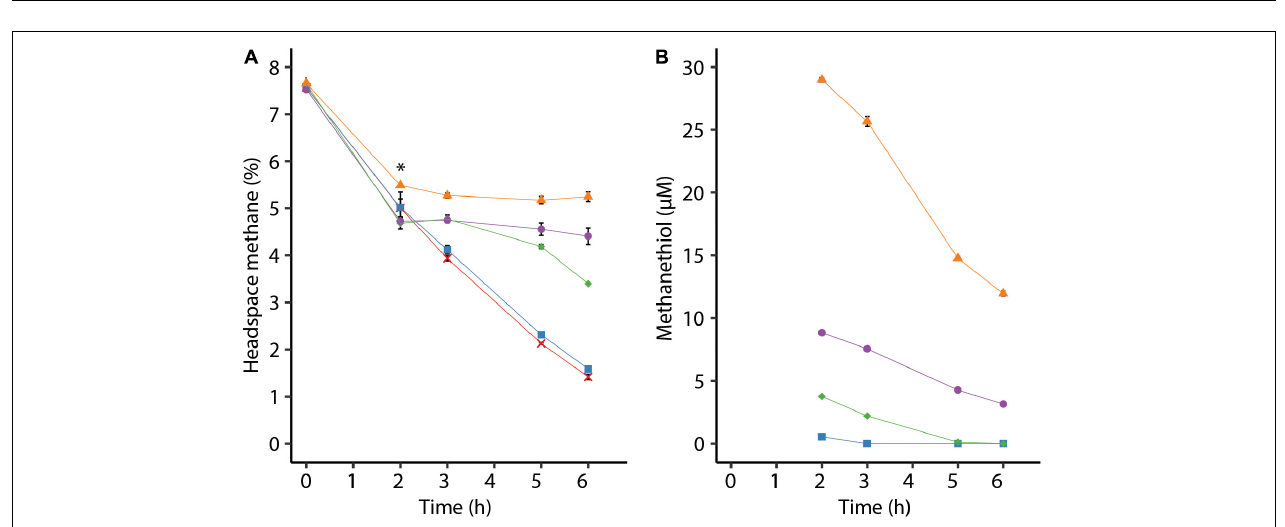
FIGURE 1 | Consumption of a liquid concentration of approximately (A) 0.5 µ M and (B) 5 µ M methanethiol by Methylacidiphilum fumariolicum SolV cells over time. The asterisk indicates the time point at which additional oxygen was added. NC, negative control with medium only.